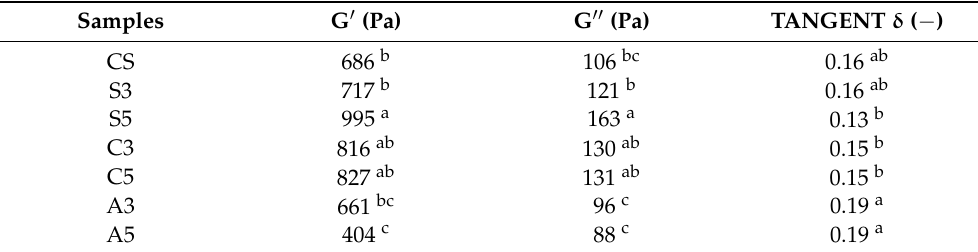
Table 4. Storage modulus (G (cid:48) ), loss modulus (G (cid:48)(cid:48) ), and tan δ at 10 Hz for different proteins at different concentrations.